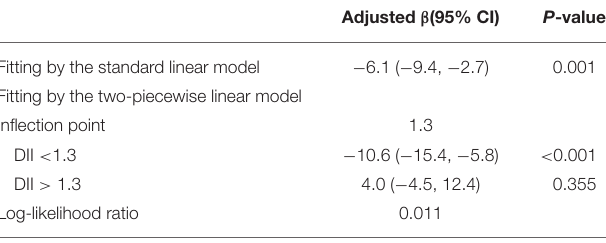
TABLE 4 | Threshold effect analysis of DII on S-Klotho using the two-piecewise linear regression